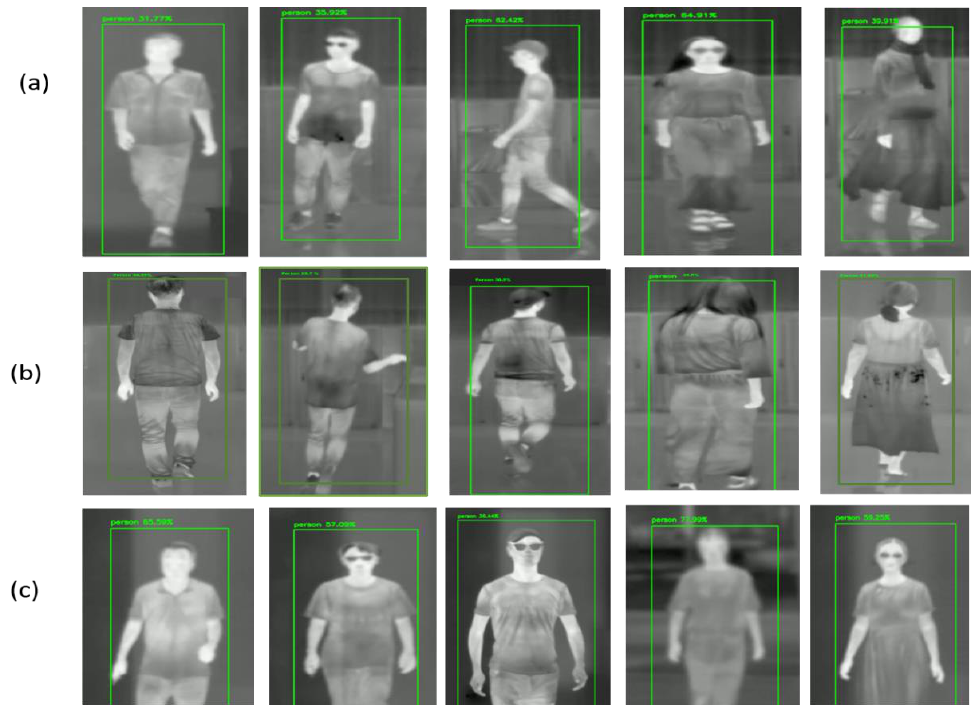
Figure 13. Evaluation tests of real-time night gait recognition on the DHU Night dataset for person classification: ( a ) the person recognition in regular walking conditions; ( b ) the person recognition in backside-walking conditions; ( c ) the person recognition using upper-body angles .